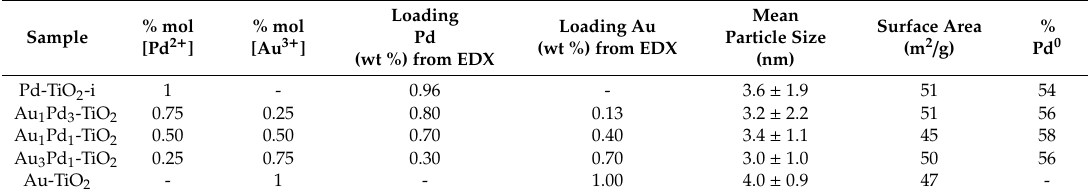
Table 3. Theoretical composition and characterisation data of the monometallic-bimetallic studies. % mol Sample [Pd 2 +